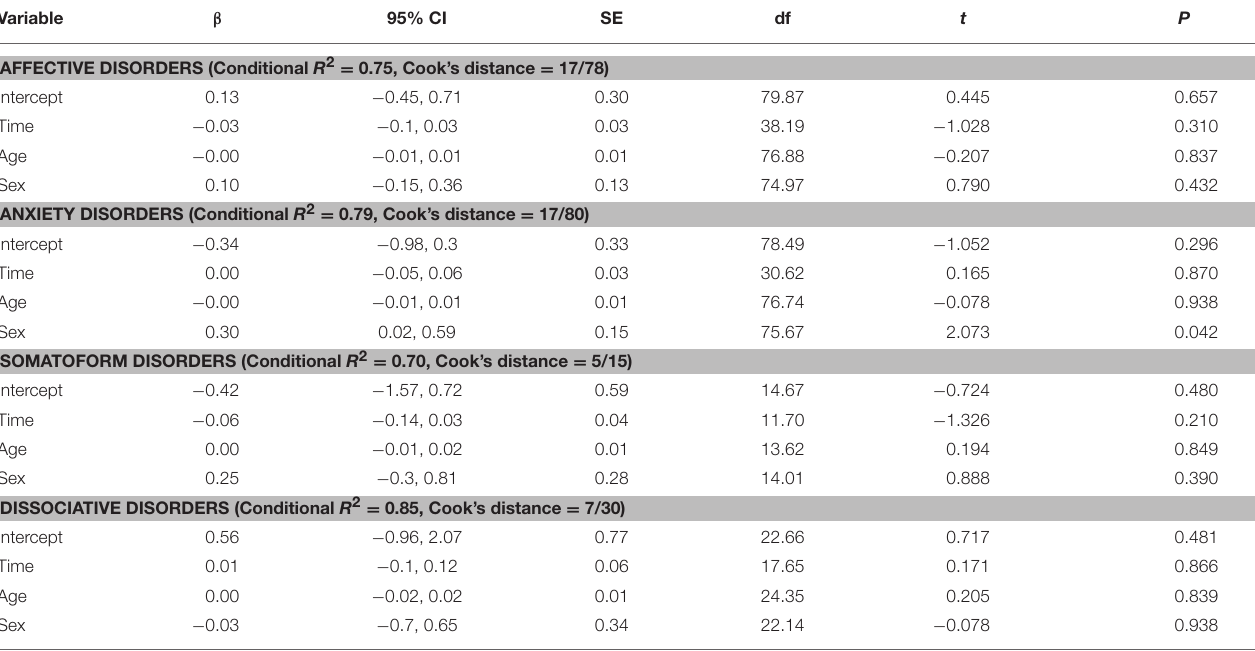
FIGURE 2 | Symptom severity during 18 months in outpatients and daycare patients ( N = 155) by DSM-IV diagnostic category. The thick red line represents the mean score across symptoms belonging to this diagnostic category and the associated ribbon the standard deviation. The colored thin lines represent the mean score across subjects of each symptom belonging to this diagnostic category. Higher scores represent higher severity. TABLE 4 | Results of linear mixed effect models on the 18-month course of symptom severity of outpatient and daycare patients ( N = 155). Variable β 95% CI SE df t